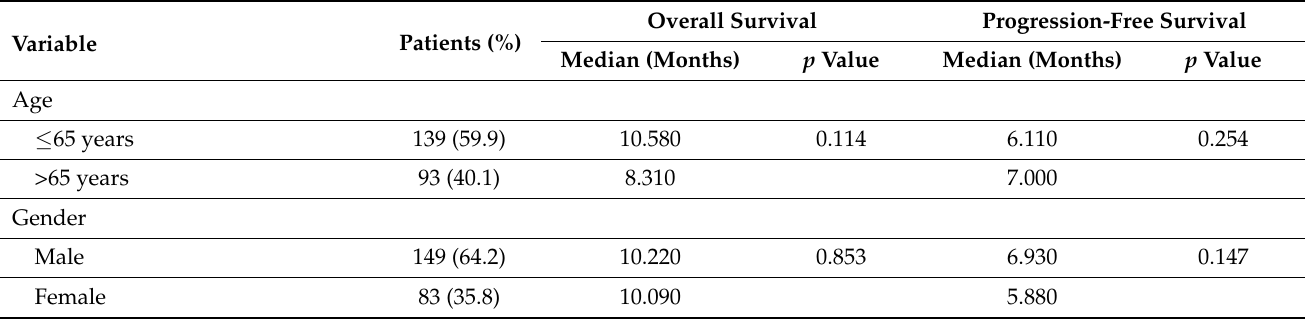
Table 1. Clinical factors affecting overall survival and progression-free survival in patients with advanced pancreatic